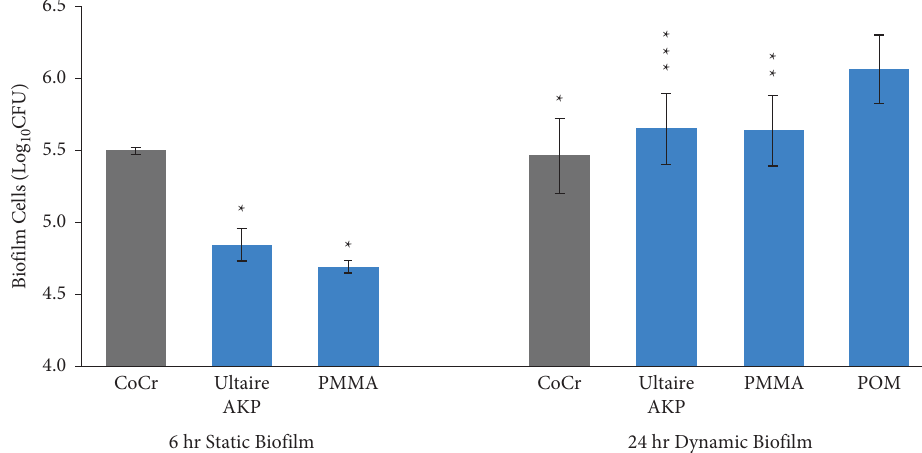
Figure 2: Streptococcus mutans and Streptococcus spp. biofilms grown on Ultaire ® AKP and traditional dental materials, quantified as colony- forming units (CFUs) recovered from coupons after incubation with S. mutans for 6 hours under static conditions or a mix of S. sanguinis (75%) and S. mutans (25%) for 24 hours under dynamic conditions. Solid bars represent mean log 10 CFU/coupon, and error bars represent standard error. Gray bars are materials with the highest number of CFUs. ∗ p < 0 . 05 vs gray bar; ∗∗ p � 0 . 10 vs gray bar; ∗∗∗ p � 0 . 101 vs gray